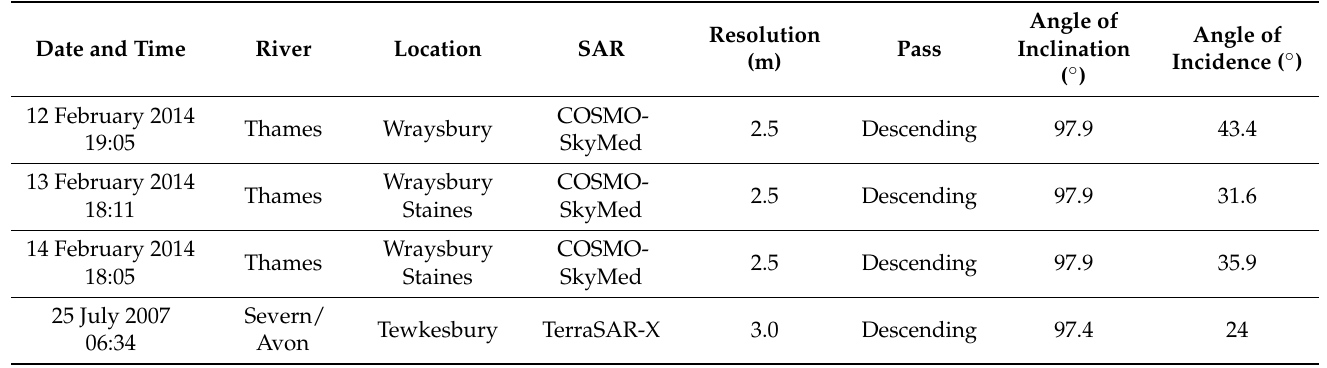
Table 1. Parameters of SAR images.